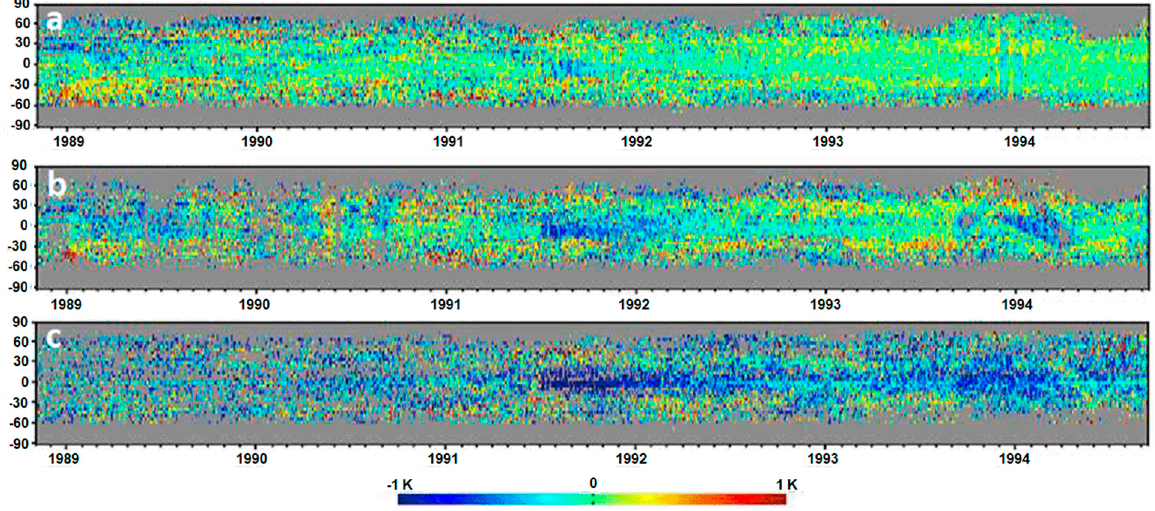
Figure 9. Hovmöller diagrams (latitude vs. time) of nighttime N11 − (D + TM) SST ( a ) RAN2 ‘sub- skin’, ( b ) CCI ‘skin’ + 0.17 K; ( c ) PF ‘skin’ + 0.17 K. (Data are from the NOAA SQUAM system [21,22]).